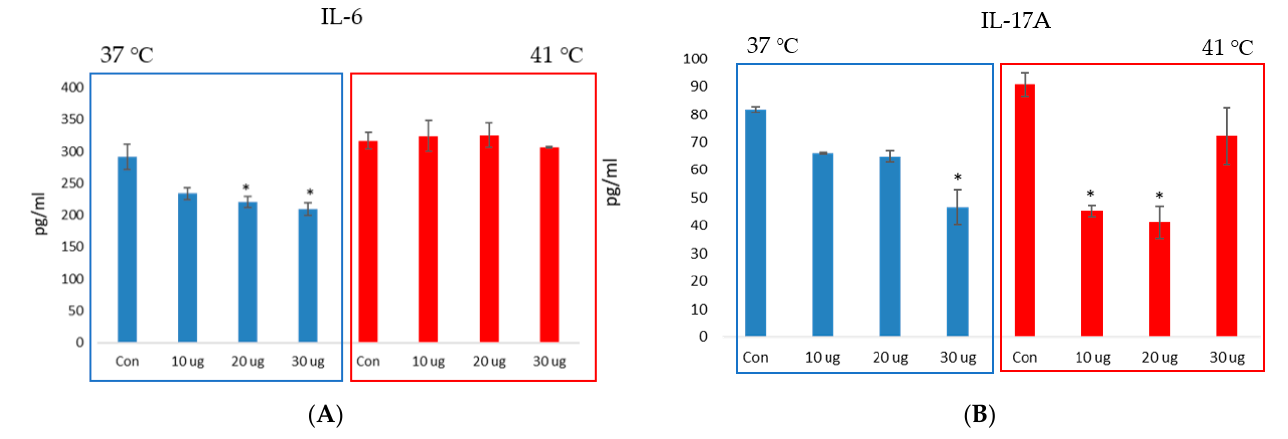
Figure 6. Effect of the RAW 264.7 macrophage cytokine IL-6 and IL-17A production of: ( A ) the blue bar means the RAW 264.7 IL-6 production at 37 °C ; red bar means the RAW 264.7 IL-6 production at 41 °C. ( B ) the blue bar means the RAW 264.7 IL-17A production at 37 °C; red bar means the RAW 264.7 IL-17A production at 41 °C. (* Treatment was presented; 10 μ g means 10c of μ g acetyl-xylogalactan/mL (culture medium); 20 μ g means 20 μ g of acetyl-xylogalactan/mL (culture medium); 30 μ g means 30 μ g of acetyl-xylogalactan/mL (culture medium)) ( p < 0.05 was marked as *).